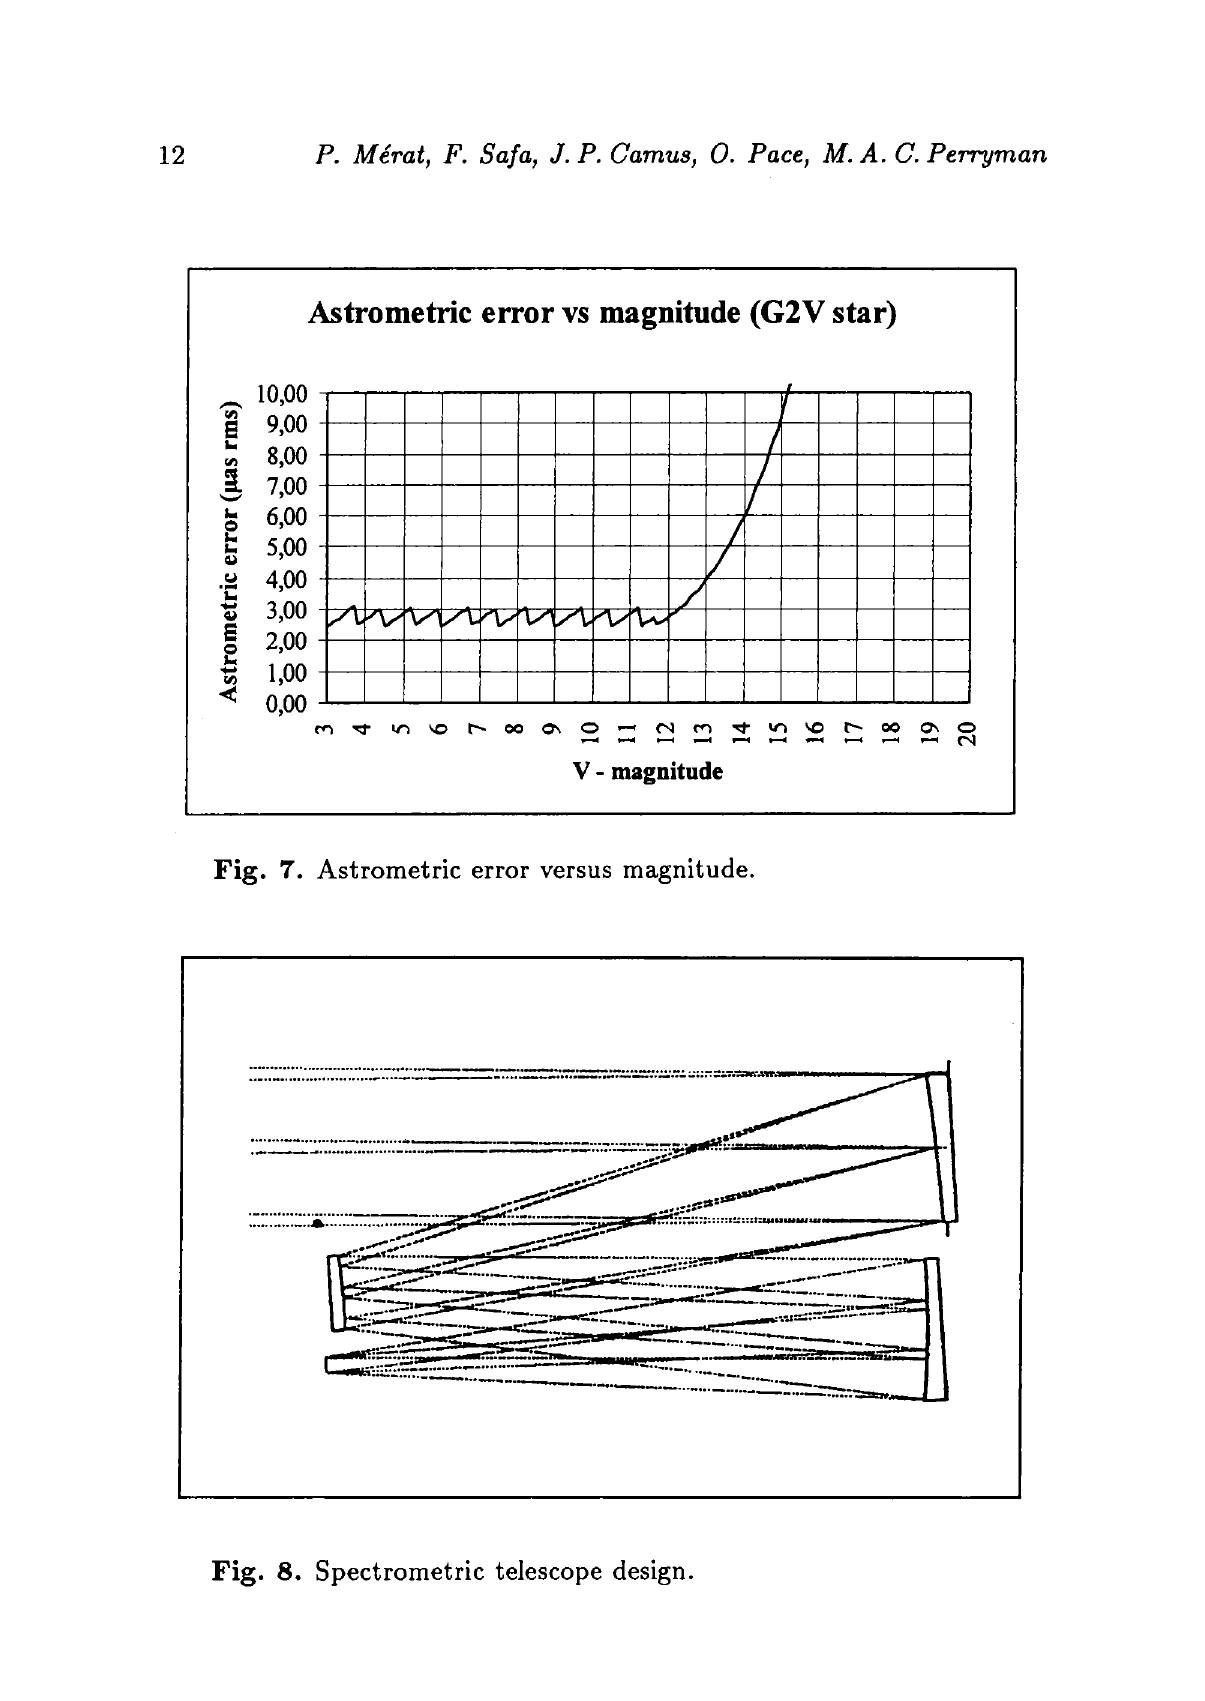
Fig. 7. Astrometric error versus magnitude.